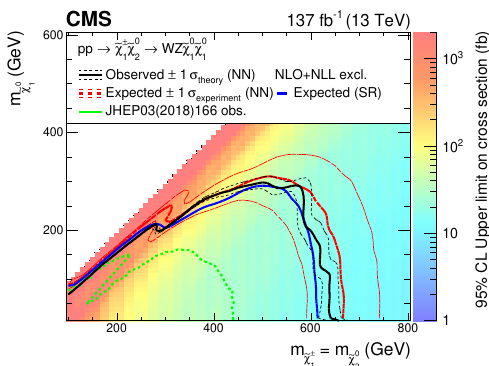
0 production with WZ -mediated decays. The Figure 19 . Interpretation of the results for e c ± 2 1 e c ± 0 shading in the m versus m plane indicates the 95% CL upper limits on the production 0 0 e c 2 1 e c e c e c 1 2 cross sections. The contours delineate the mass regions excluded at 95% CL when assuming cross sections computed at NLO plus NLL. The observed, observed ± 1 σ ( ± 1 standard deviation of theory the theoretical cross sections), median expected, and expected ± 1 σ bounds obtained with experiment the neural network strategy are shown in black and red. The median expected bound obtained with the search region strategy is shown in blue. The observed limits obtained in the CMS analysis using 2016 data [20] are shown in green.